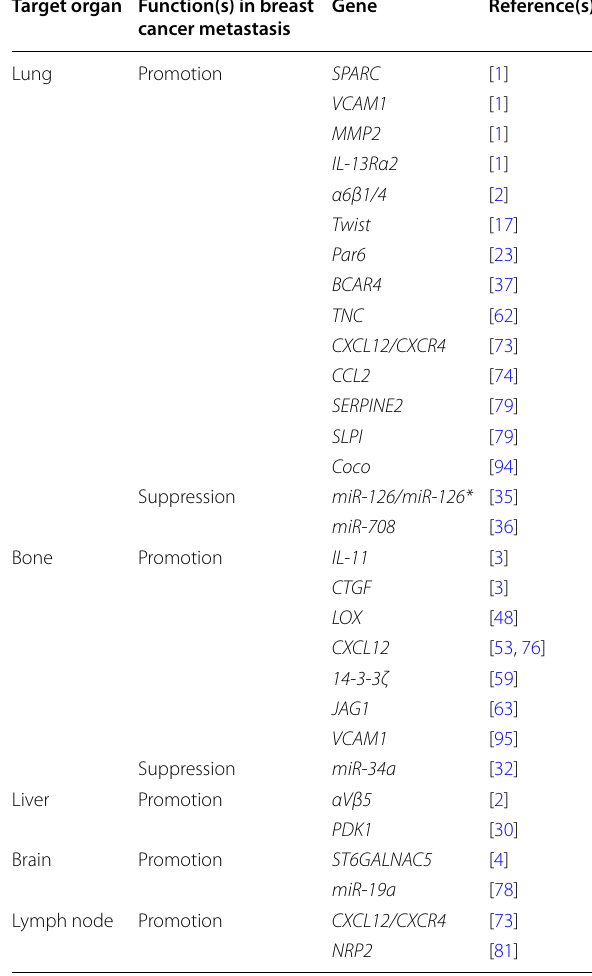
SPARC , secreted protein acid and rich in cysteine; VCAM1 , vascular cell adhesion molecule 1; MMP2 , matrix metallopeptidase 2; IL-13Rα2 , interleukin-13 receptor subunit alpha-2; Par6 , partitioning-defective protein 6; BCAR4 , breast cancer anti-estrogen resistance 4; TNC , tenascin C; CXCL12 , C–X–C motif chemokine ligand 12; CXCR4 , C–X–C motif chemokine receptor 4; CCL2 , C–C motif chemokine ligand 2; SERPINE2 , serpin family E member 2; SLPI , secretory leukocyte peptidase inhibitor; miR , microRNA; IL-11 , interleukin-11; CTGF , connective tissue growth factor; LOX , lysyl oxidase; JAG1 , Jagged 1; PDK1 , pyruvate dehydrogenase kinase 1; ST6GALNAC5 , ST6 N -acetylgalactosaminide alpha-2,6-sialyltransferase 5; NRP2 , neuropilin 2 and stromal cells, ECM, and the lymphatic and vascular systems [10]. Stromal cells include immune cells, can- cer-associated fibroblasts (CAFs), pericytes, and mesen- chymal stem cells (Table 2). Secreted bioactive molecules by both tumor and stromal cells include growth factors, cytokines, chemokines, and exosomes [2, 10–13]. On the one hand, breast cancer cells educate the surrounding microenvironment to facilitate their invasion, survival, and growth in the manner of autocrine and paracrine. On the other hand, the tumor microenvironment adversely